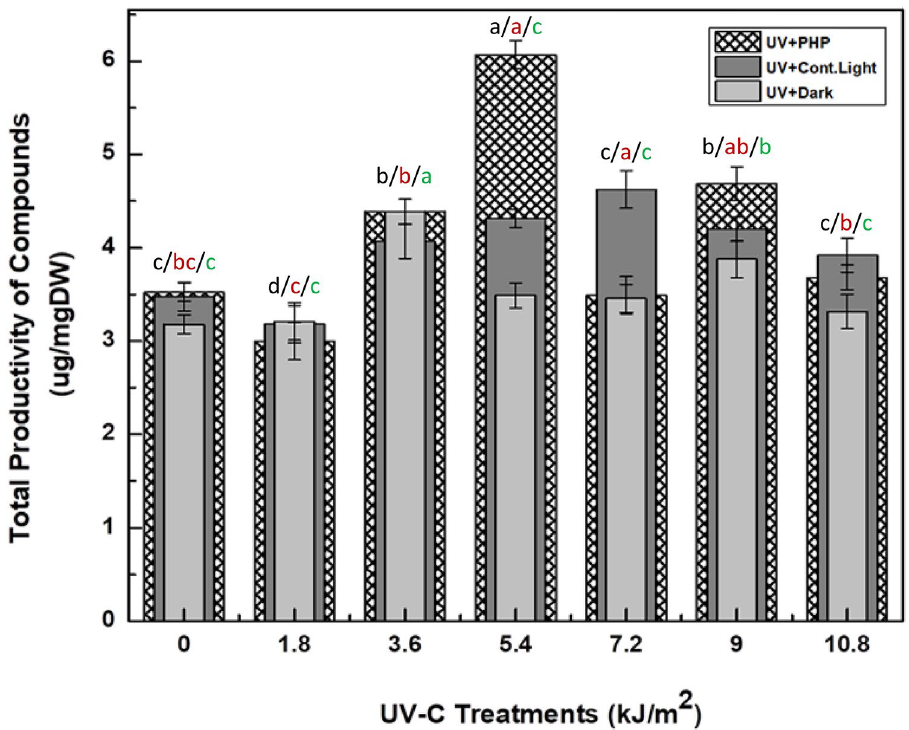
Figure 5. Productivity of 11 different phenolic compounds quantified via HPLC, in callus cultures of Fagonia indica after elicitation with UV-C radiations (0–10.8 kJ/m 2 ) and maintained in different light regimes; cont. light (24 h), dark (24 h) and photoperiod (PHP, 16L/8D h). Values represented as mean ± SE of three replicates. Different (black for UV + PHP, red for UV + cont light, green for UV + dark) letters represent significant differences between the various experimental conditions ( p < 0.05).